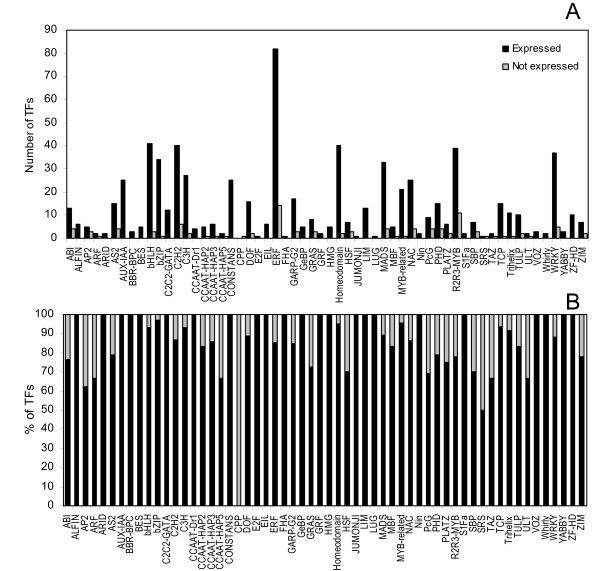
Tobacco TF expression. 772 of the 2513 TOBFAC TFs were mapped by BLAST searches to 850 probe sets on the tobacco microarray (See methods). Bar charts show the number (A) and percentage (B) of probe sets representing transcription factors in each TOBFAC family that were identified as expressed in at least one TobEA tissue type. Black bars represent the number/percentage of expressed genes and grey bars the non-expressed genes. TF families are identified along the x-axis.